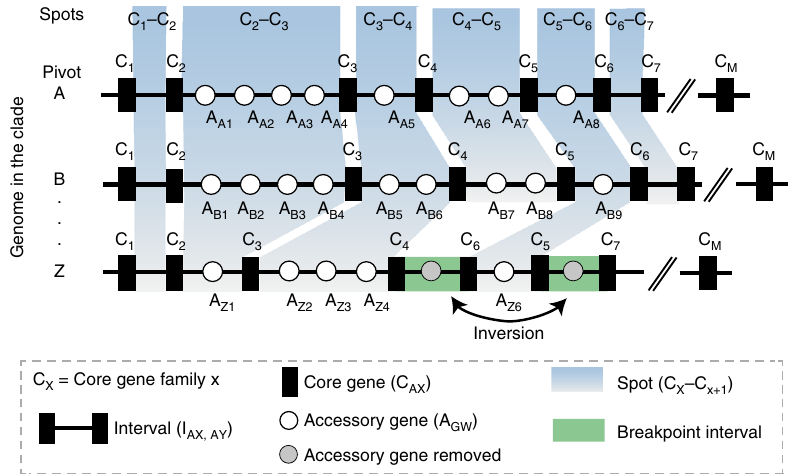
Fig. 1 Scheme depicting key concepts used in this study. Intervals fl anked by the same core gene families (C X , C Y ) as those from pivot genome A were de fi ned as syntenic intervals (i.e., the members of the core gene families X and Y were also contiguous in the pivot). The intervals that do not satisfy this constraint were classed as breakpoint intervals ( green-shaded regions) and excluded from our analysis. For every interval in the pivot genome, we de fi ned spot as the set of intervals fl anked by members of the same core gene families ( blue-shaded regions) NATURE COMMUNICATIONS | 8:841 | DOI: 10.1038/s41467-017-00808-w |